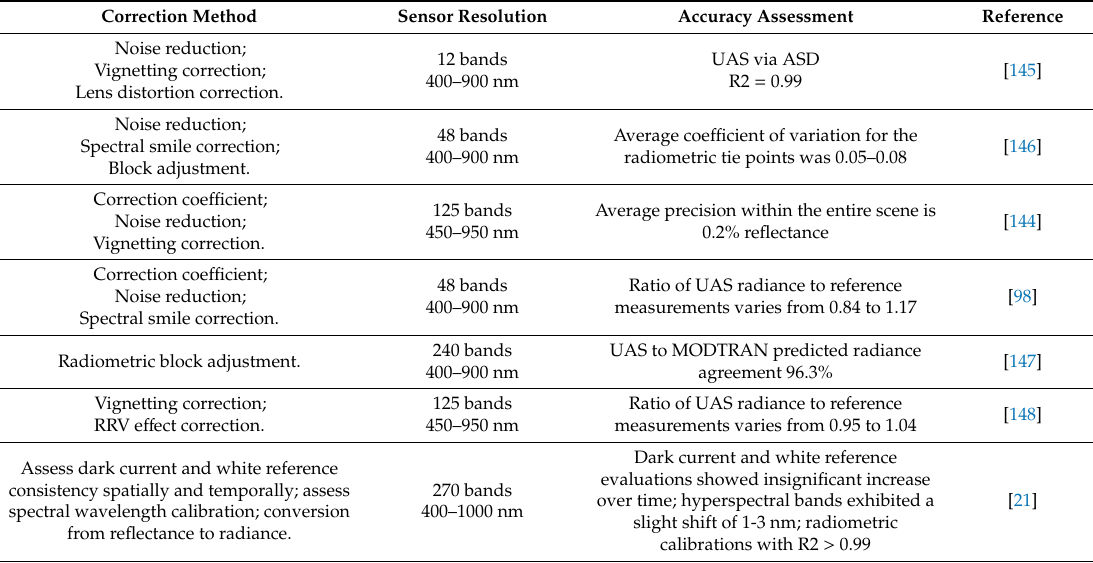
Table 4. Impact of di ff erent correction methods on UAS-based radiometric